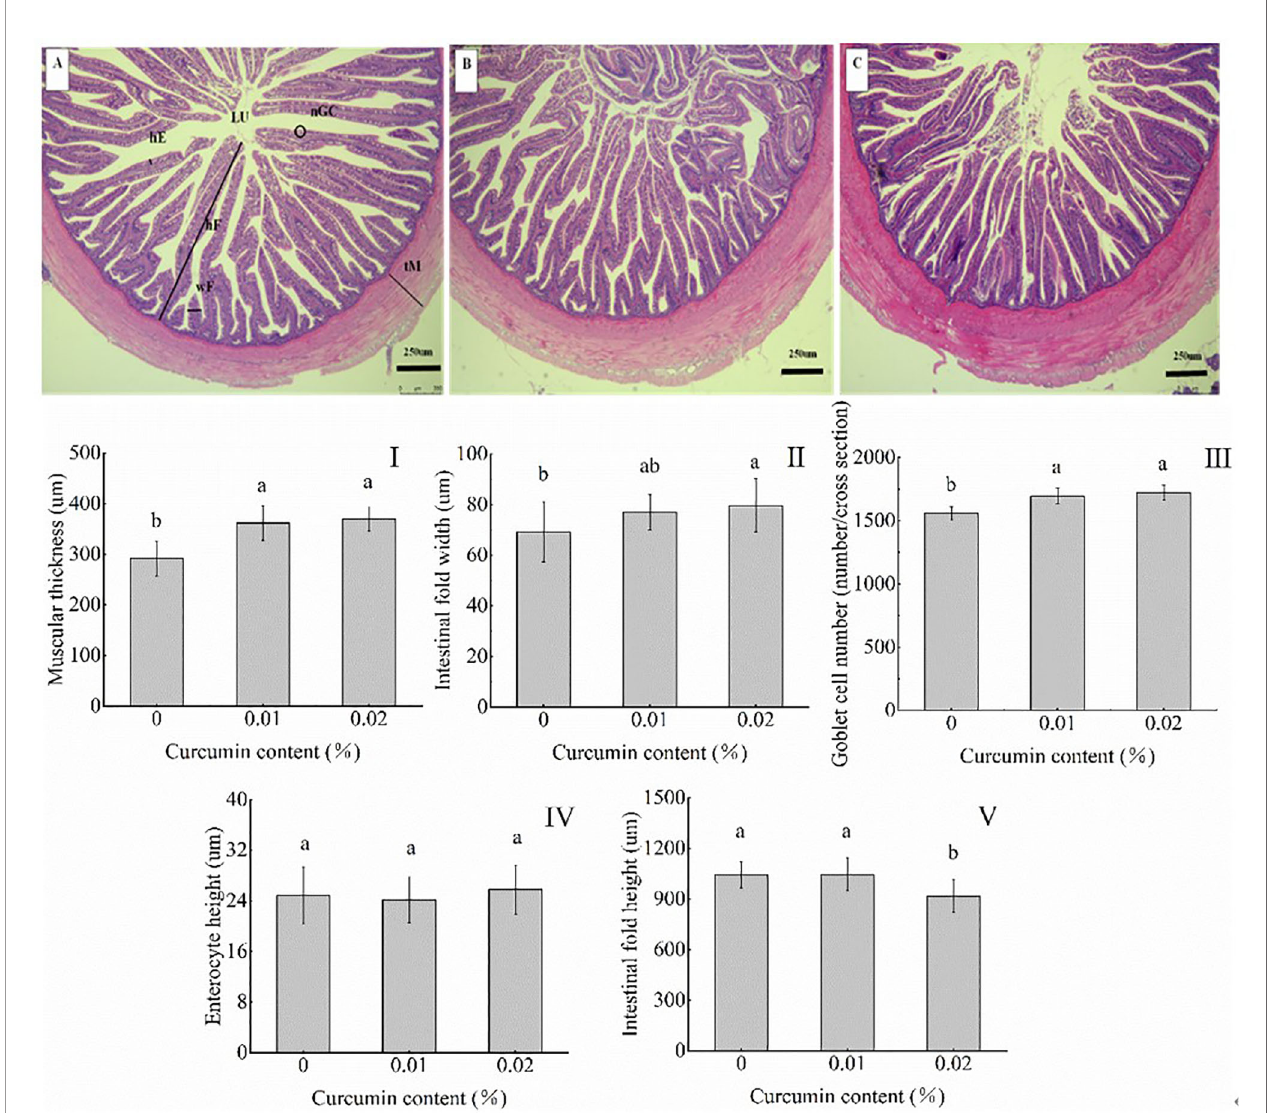
FIGURE 2 | The intestinal tract of Seriola dumerili was affected by diets with different curcumin contents. Representative sections of intestinal tissue (50 magni fi cation) are shown at the top [ (A) control group; (B) 0.01% treatment group; (C) 0.02% treatment group]. tM represents muscle layer thickness; hF represents the height of intestinal fold; wF represents the intestinal fold width; hE stands for intestinal epithelial cell height; nGC represents the number of goblet cells; LU represents lumen. (I, muscle layer thickness; II, intestinal fold width; III, number of goblet cells; IV, intestinal epithelial cell height; III, intestinal fold height). Different superscript letters indicate signi fi cant differences between different treatments (p <